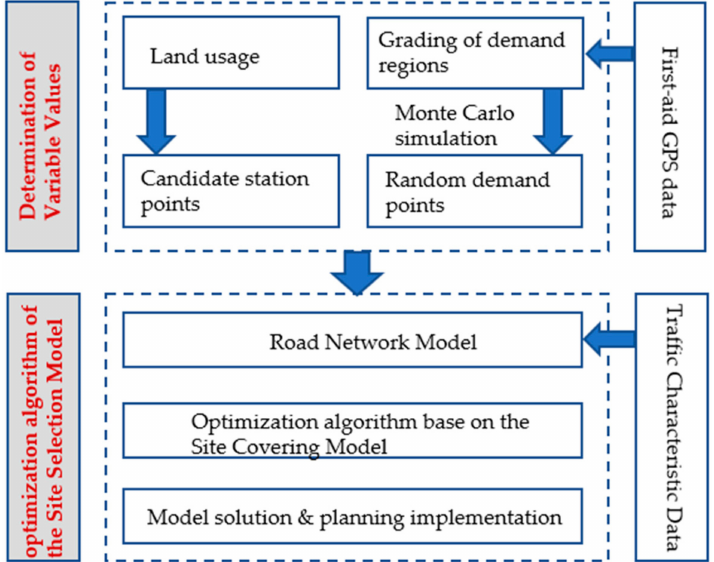
Figure 2. The framework of the